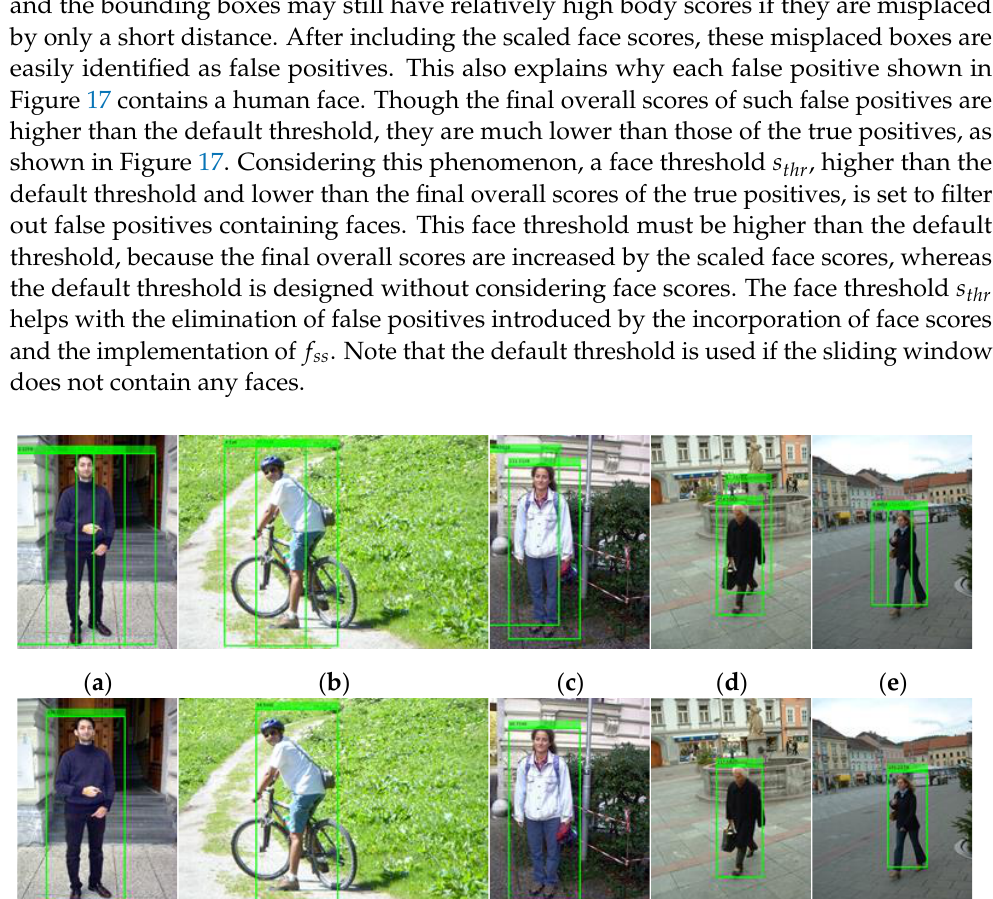
Algorithm 1 : Procedure used by the integrated detector